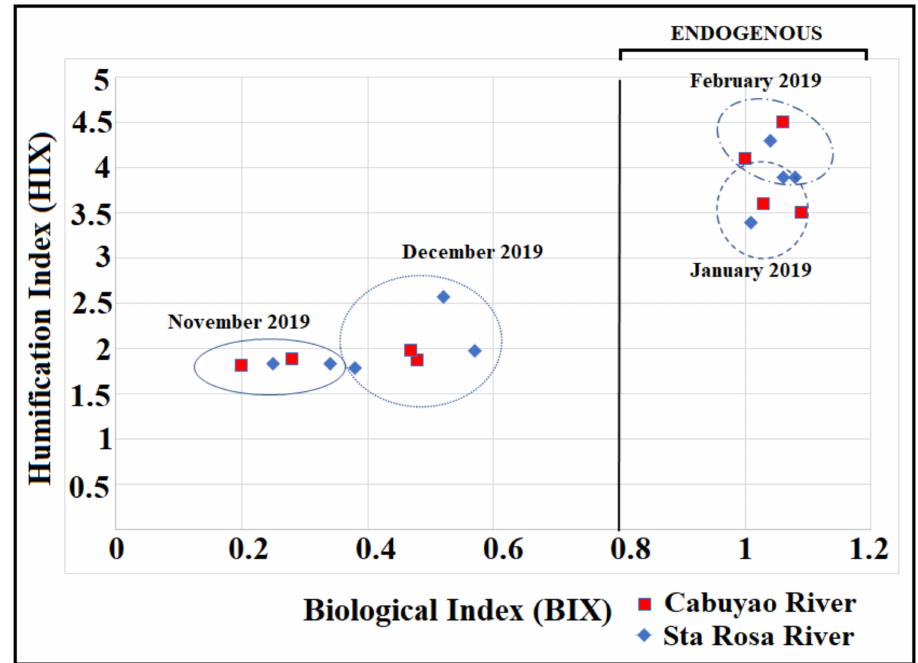
Figure 7. Index distributions of BIX vs. HIX from November 2019 to February 2020. These peaks are usually associated with humic substances and vary in its source and molecular size (Figure 8). High aromaticity and molecular size were observed in all downstream sampling stations based on the absorbance ratio at A250/363 which is supported by the high values of Peak C and Peak A (Figure 4).